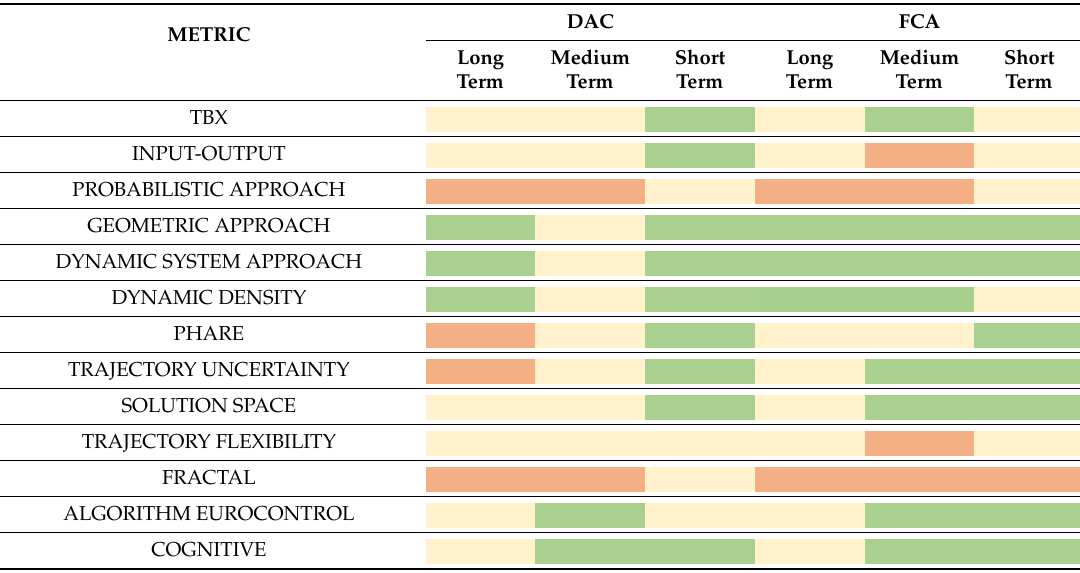
Table 8. Level of di ffi culty to adapt a